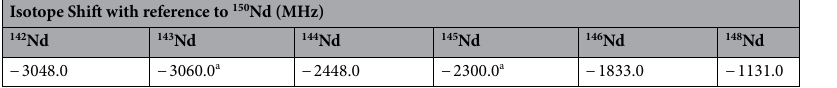
Isotope Shift with reference to 150 Nd (MHz) Table 2. Isotope shifts 17 of the Nd isotopes for the 562.2086 nm first excitation transition with reference to the 150 Nd isotope. a Isotope shifts of odd 143 Nd and 145 Nd isotopes has been calculated using the King’s plot analysis.